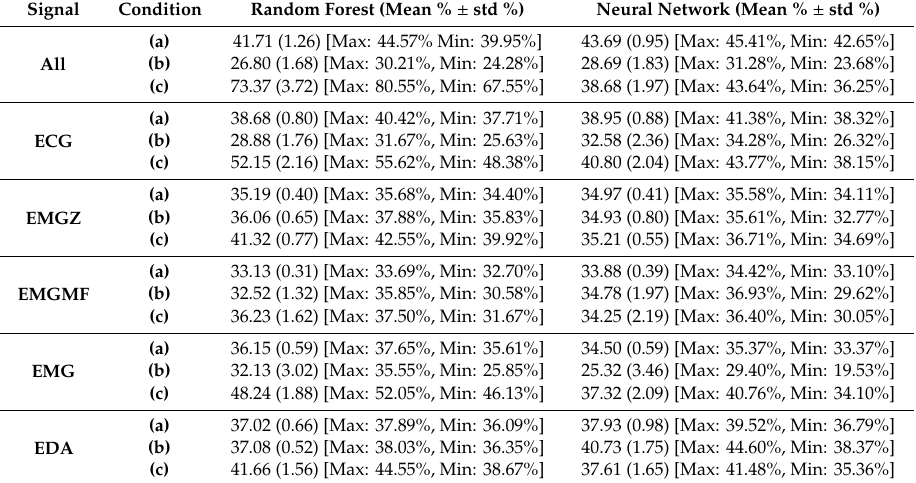
Table 5. Global results for 60s frame. The mean (standard deviation) [Maximum Minimum] F1 score obtained for the 60s classifiers in each iteration; (a) corresponds to the subject independent evaluation, (b) corresponds to the subject dependent evaluation, and (c) corresponds to emotion dependent